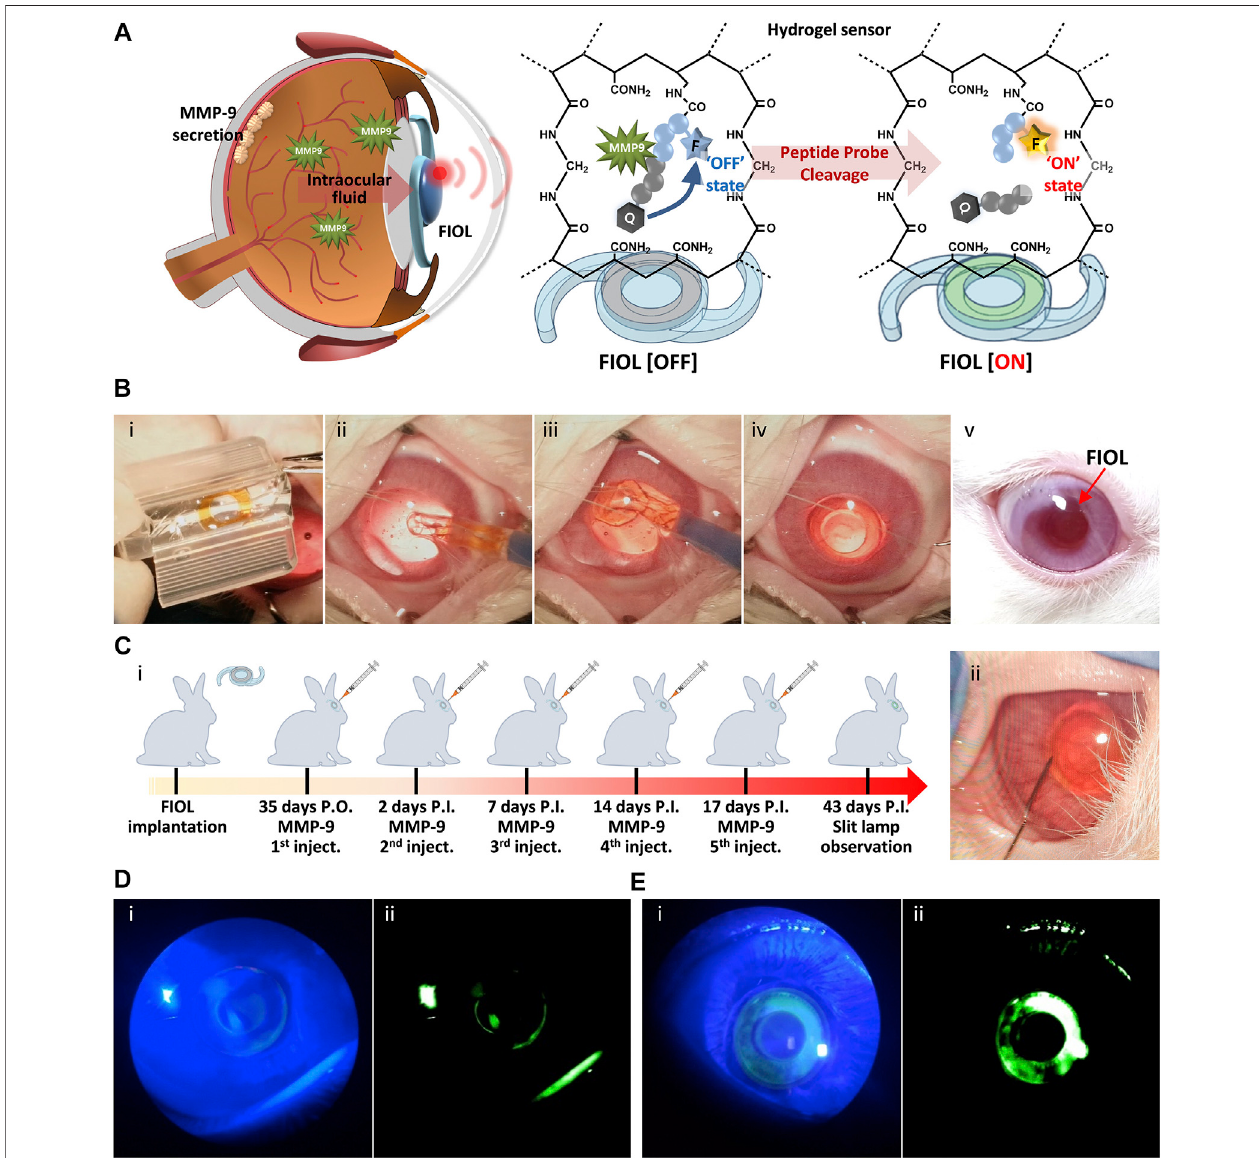
FIGURE 6 | In vivo monitoring of MMP-9 using FIOL. (A) Schematic illustration of the reaction mechanism of FIOL implanted inside the eye. (B) Representative photographsoftheprocessofFIOLimplantationduring invivo rabbitcataractsurgery: (i) LoadingofFIOLintothecartridgeoftheinjector, (ii,iii) InsertionofFIOLintothe posterior chamber ofthe eyeand (iv) fi nalimplantationstatusofFIOL in the eye. (v) FIOL implanted inthe eye maintained proper position without any adverse response, including immune reactions, over 7 weeks postoperatively. (C) (i) Schematic illustration of in vivo testing for MMP-9 sensing of FIOL inside the eye and (ii) representative photograph ofintraocular MMP-9 injection after FIOL implantation. Slit-lamp photographs of FIOL inside the eyeafter (D) 2 days P.I. and (E) 43 days P.I., with (i) cobalt blue fi ltered light and (ii) green fi ltered images, respectively. Reprinted from Shin et al. (2020), with the permission of Elsevier.